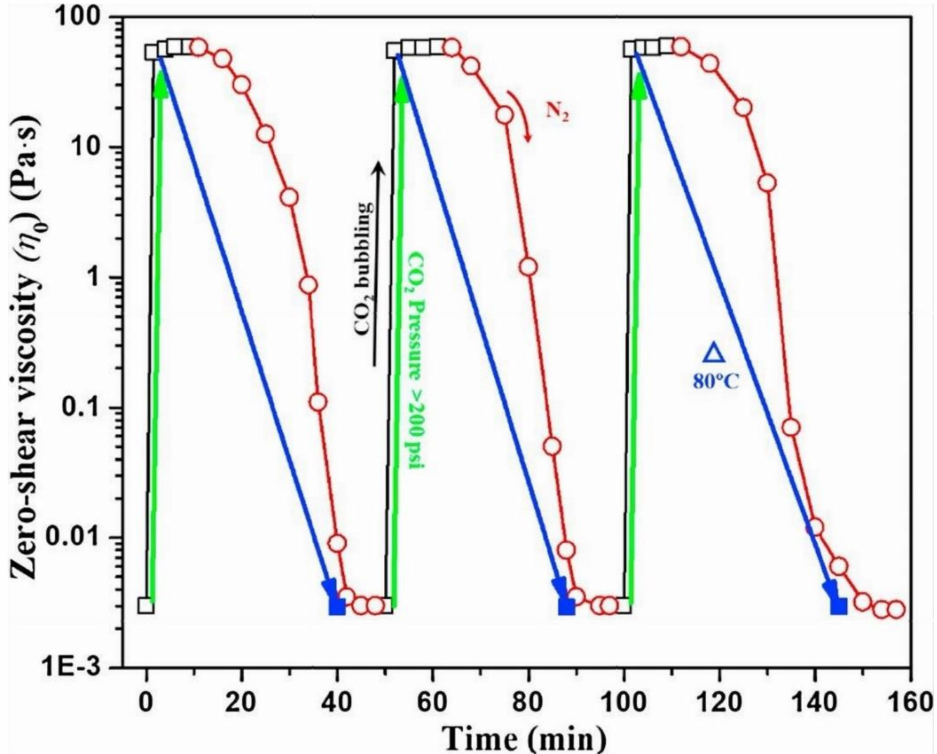
Figure 9. At atmospheric temperature and pressure (unless when gel-breaking at 80 ◦ C), 3% erucami- dopropyl dimethylamine (EA) solution with switchable zero-shear viscosity [32].